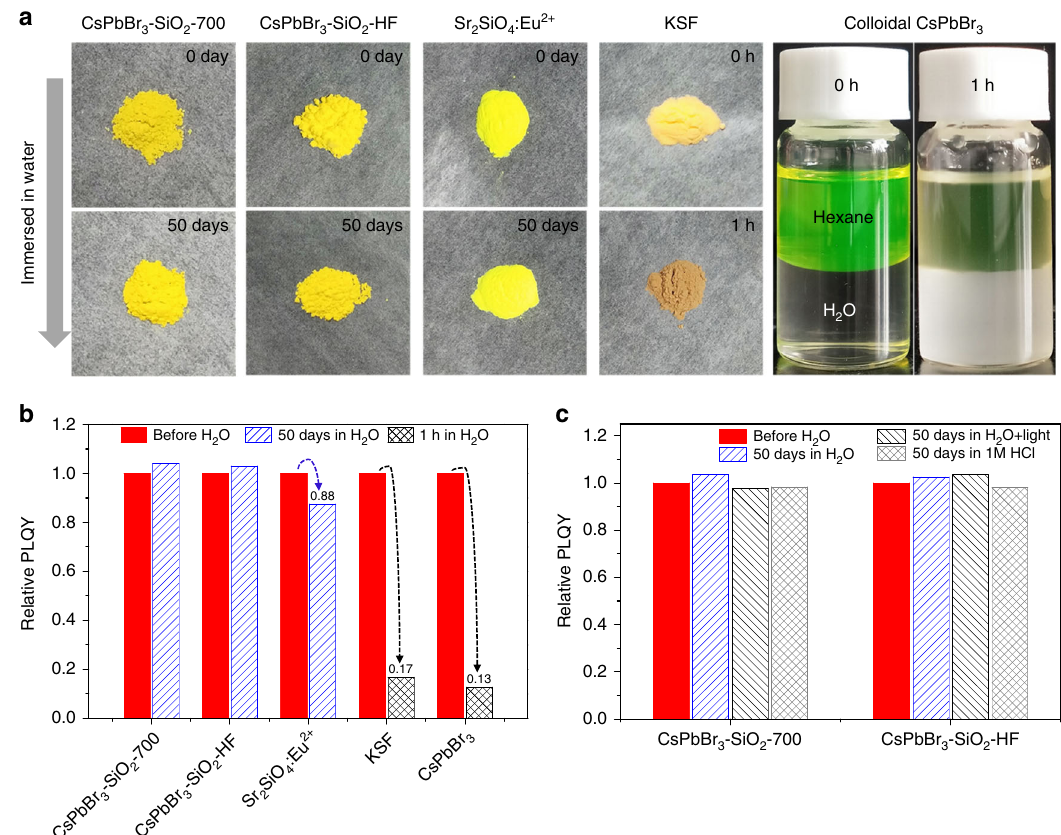
Fig. 5 Water resistance and acid resistance of CsPbBr 3 -SiO 2 . Photographs ( a ) and relative PLQYs ( b ) of the CsPbBr 3 – SiO 2 – 700, CsPbBr 3 – SiO 2 – HF, ceramic Sr 2 SiO 4 :Eu 2 + green phosphor, KSF red phosphor, and colloidal CsPbBr 3 NCs after immersed in water for various times. c Relative PLQYs of the CsPbBr 3 – SiO 2 – 700 and CsPbBr 3 – SiO 2 – HF after immersed in various solvents for 50 days, extra light source: a 450 nm LED light (175mW cm − 2 ).